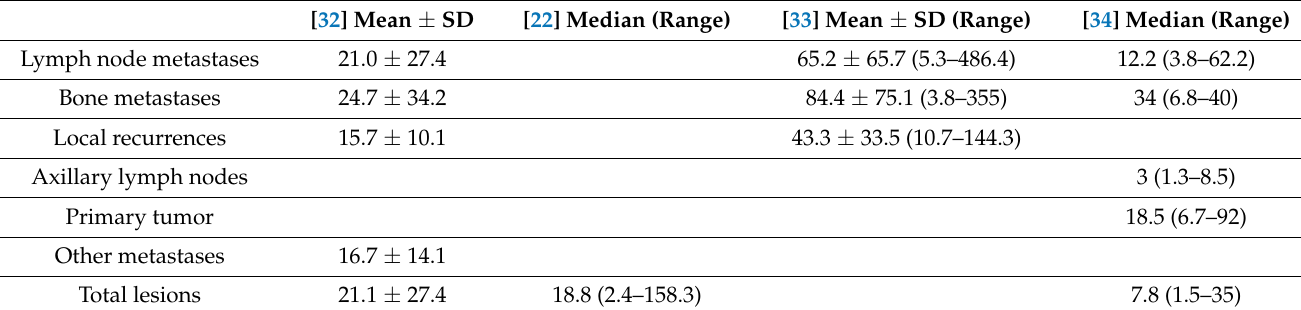
Table 1. Overview of T/B ratios in several studies concerning 68 Ga-PSMA PET/CT imaging. The T/B ratio was either computed with the tumor uptake and the SUV mean obtained from a region of interest (ROI) drawn in gluteal muscle [22,32,33] or tumor uptake and the SUV mean from adjacent healthy tissue